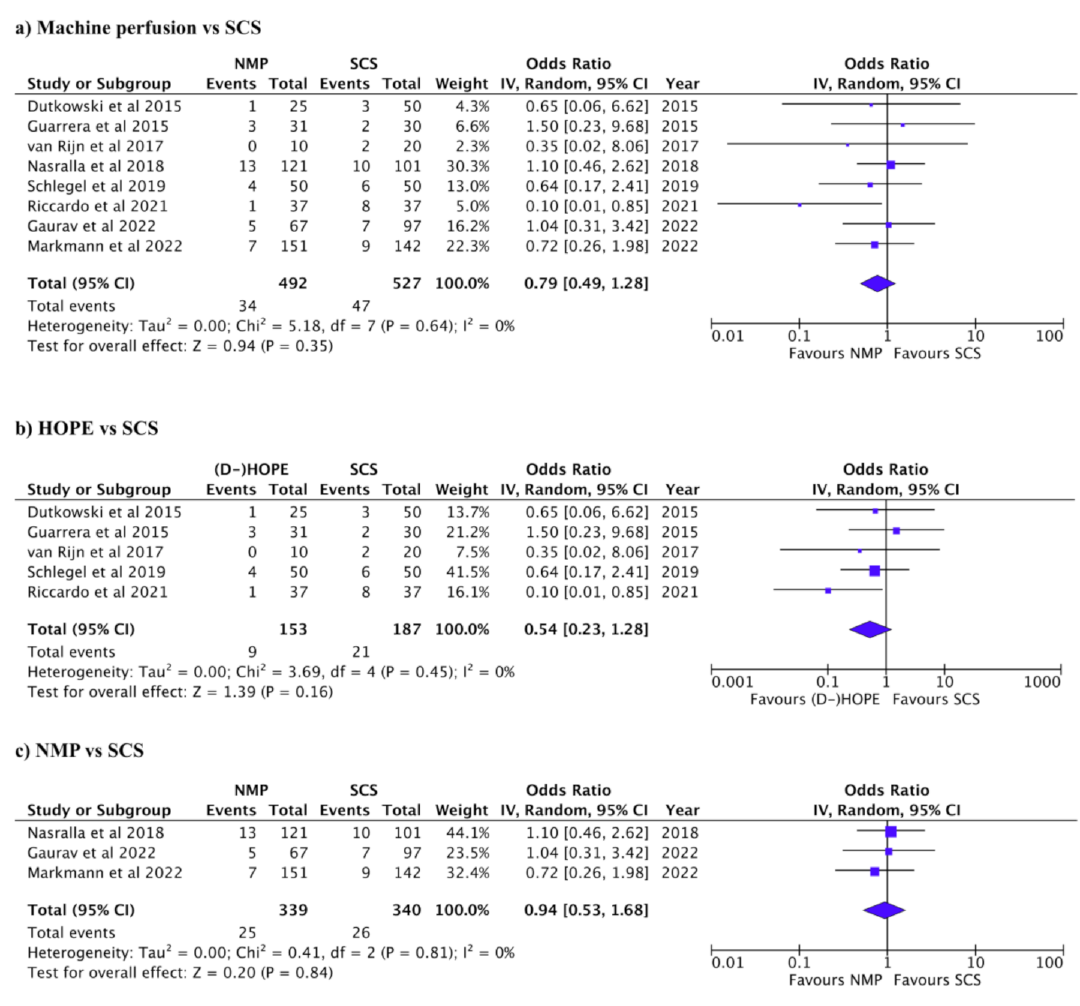
Figure 3. Forest plots for vascular complications. ( a ) Machine perfusion (hypothermic or normother- mic) vs. SCS ( P = 0.35). ( b ) HOPE vs. SCS ( P = 0.16). ( c ) NMP vs. SCS ( P =